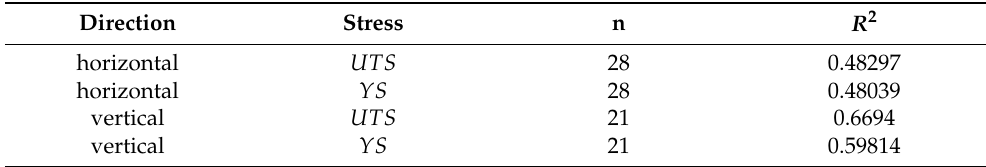
Table 4. The number of points in the data set, n , for the linear regression model and their associated correlation coefficient, R 2 , for NP1.